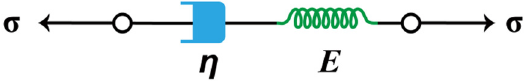
Figure 5: Maxwell